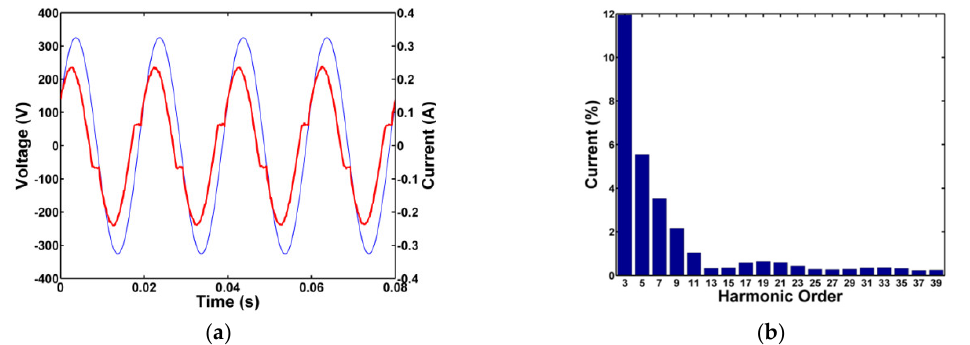
Figure 4. Waveforms of instantaneous values of current and voltage ( a ) for luminaire marked as LUM2 and ( b ) current harmonic spectrum.